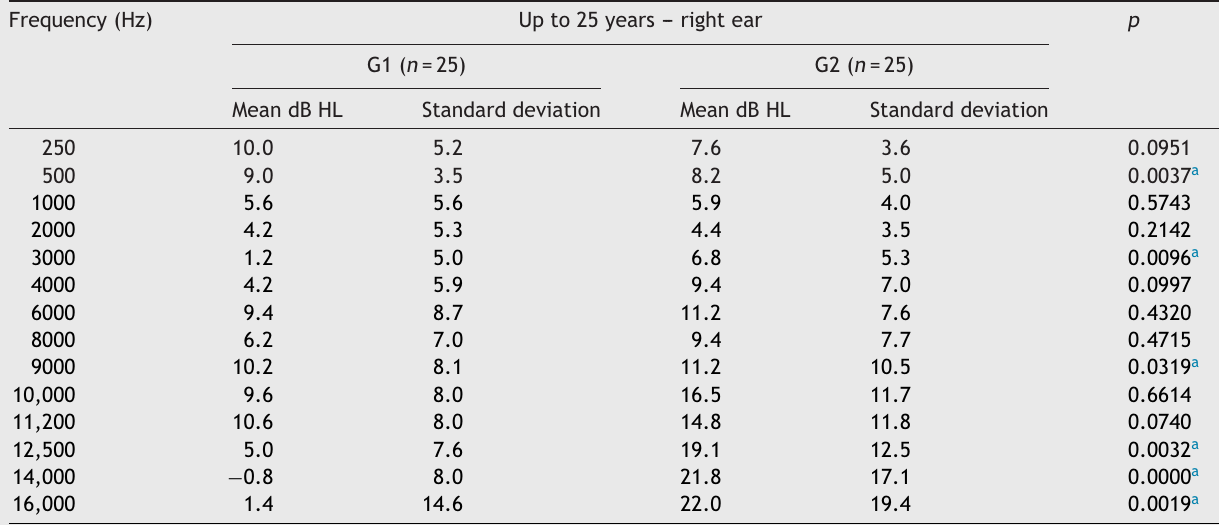
Mean right ear hearing thresholds, per frequency, for age up to 25 years ( n =